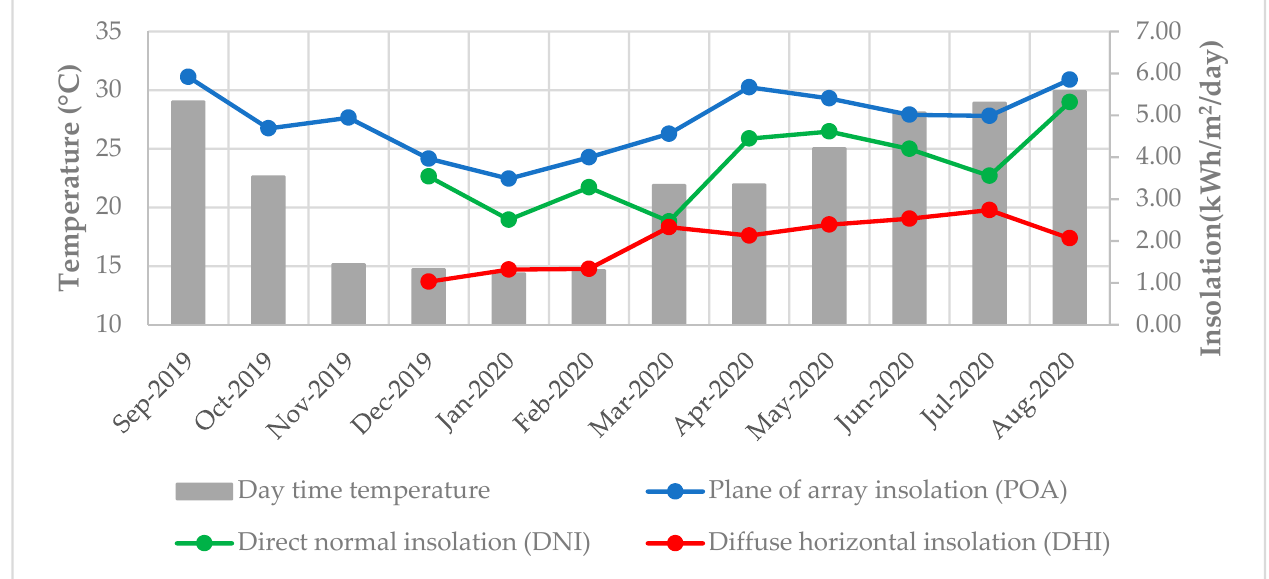
Figure 4. Ambient temperature and insolation from September 2019 to August